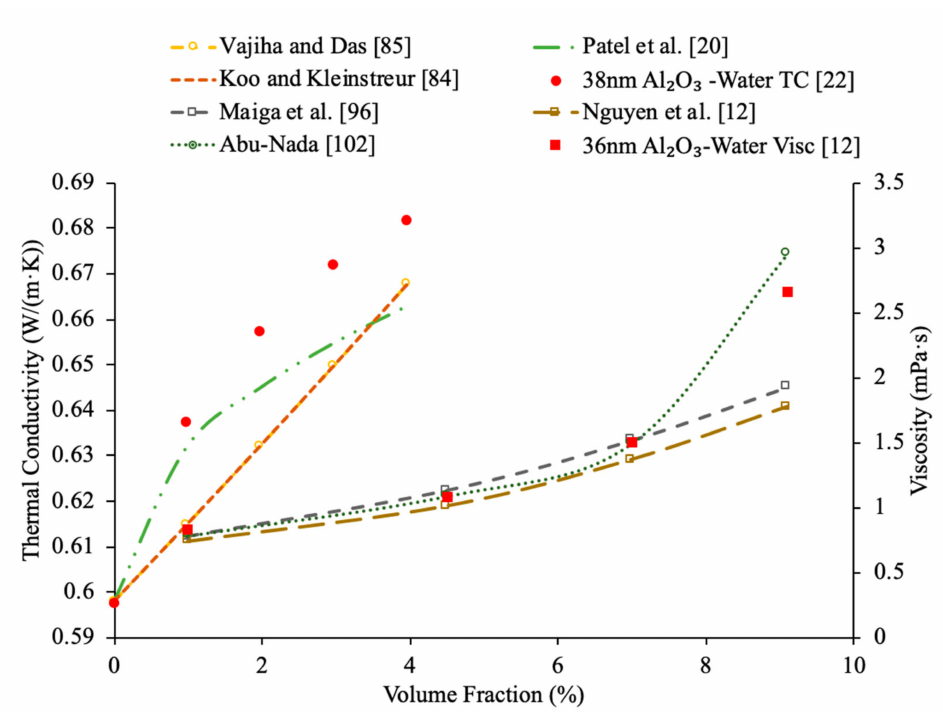
Figure 40. Thermal conductivity (TC) and viscosity (Visc) as a function of volume fraction for 36 and 38 nm Al 2 O 3 –water nanofluids [12,22] in comparison to various theoretical mod- els